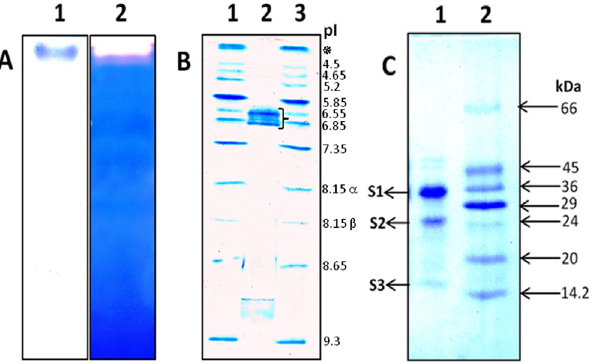
Fig 2. Biochemical characterisation of cupincin. A) Lane 1: Native PAGE (10% T, 2.7% C) of the purified cupincin. Lane 2: Gelatin-embedded PAGE for detecting protease activity stained with coomassie brilliant blue. ( B) Iso electric focusing: Lane 1: Broad range pI calibration kit (pI- 3 to10, ✵ -amyloglucosidase- coloured pI marker, 8.15 α -lentil lectin-acidic band, 8.15 β -lentil lectin-middle band). Lane 2: Iso electric point of cupincin was determined to be 6.6 – 6.8, while focussing in the pI range of 3 – 9, flower bracket indicating the cupincin bands, Lane 3: Broad range pI calibration kit (pI 3 – 10). ( C) . SDS-PAGE (10%T, 2.7% C) of purified cupincin, Lane 1: Purified cupincin, Lane 2: M r Markers.